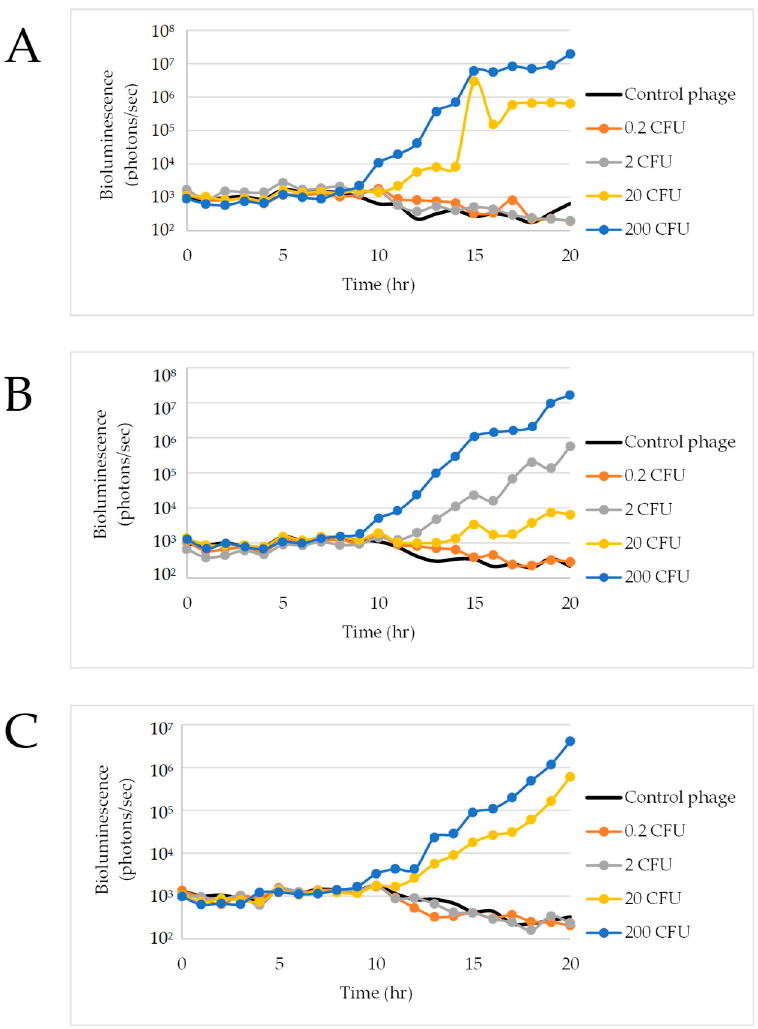
Figure 7. Φ V10 nluc infectivity in 325 mL mTSB Nalgene bottles. Replicates ( A ) 1, ( B ) 2, and ( C )